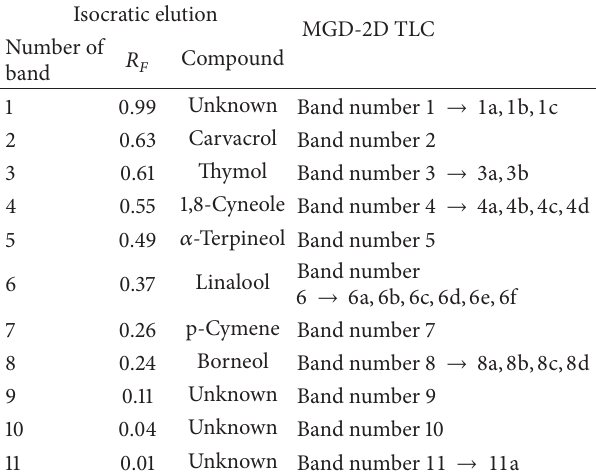
Table 4: The comparison of efficiency of ThymiOleum separation by means of two methods: isocratic elution and MGD-2D TLC. The identification of particular compounds was performed according to 𝑅 𝐹 values given in the